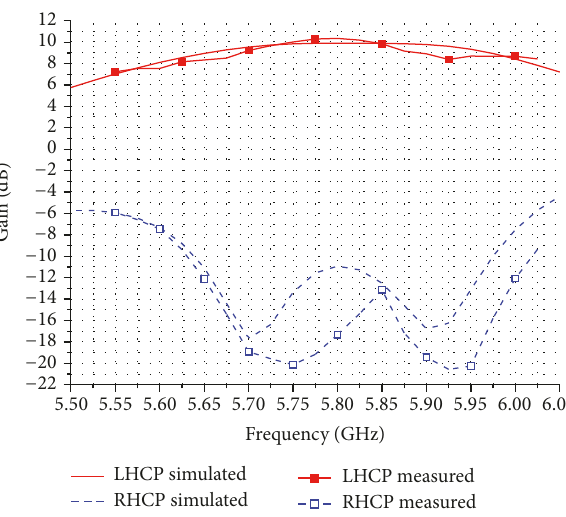
Figure 16: Simulated and measured LHCP gain and RHCP gain of the 1 × 2 linear array.